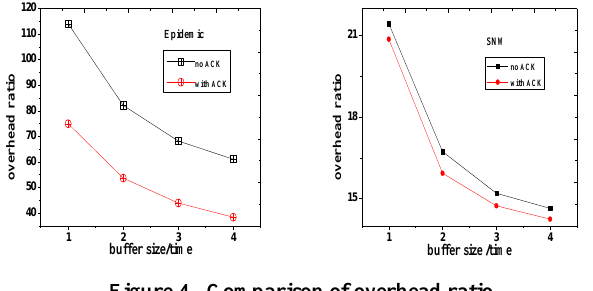
Figure 4. Comparison of overhead